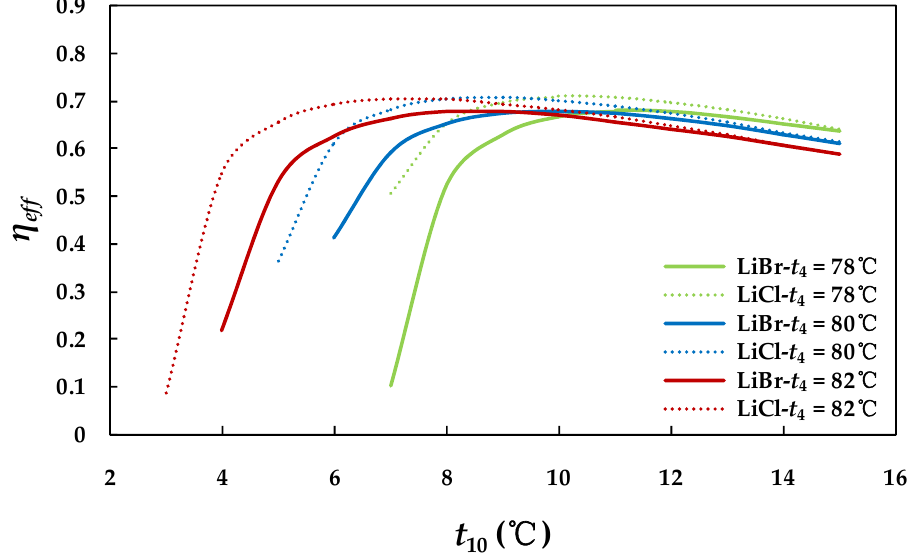
Figure 10. Evaporator temperature impact on the efficiency ratio of absorption system under various generator temperature levels (78 °C, 80 °C, and 82 °C) for the two working pairs (t 1 = t 8 = 40 °C, ε = 0.7).